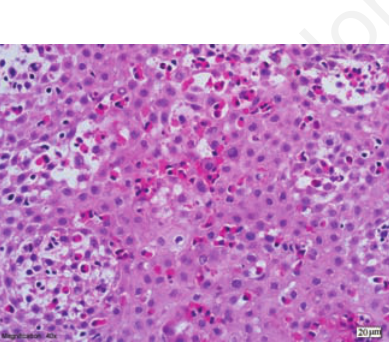
Figure 1. Pretreatment photomicrograph of upper esophageal biopsy of Case #2. Histological examination of mucosal esophageal biopsy demonstrated numerous intraepithelial eosinophils, eosinophilic microabcesses consistent with eosinophilic esophagitis (Hematoxylin & Eosin,